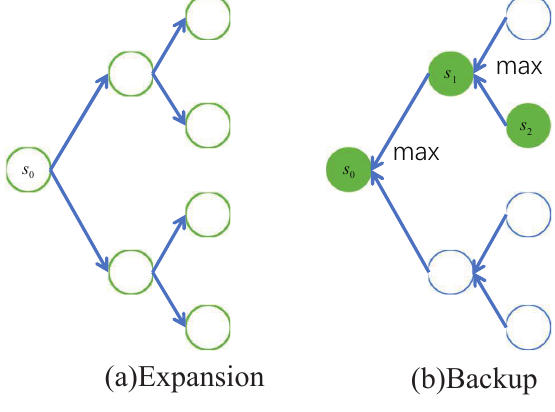
Figure 4. K-step